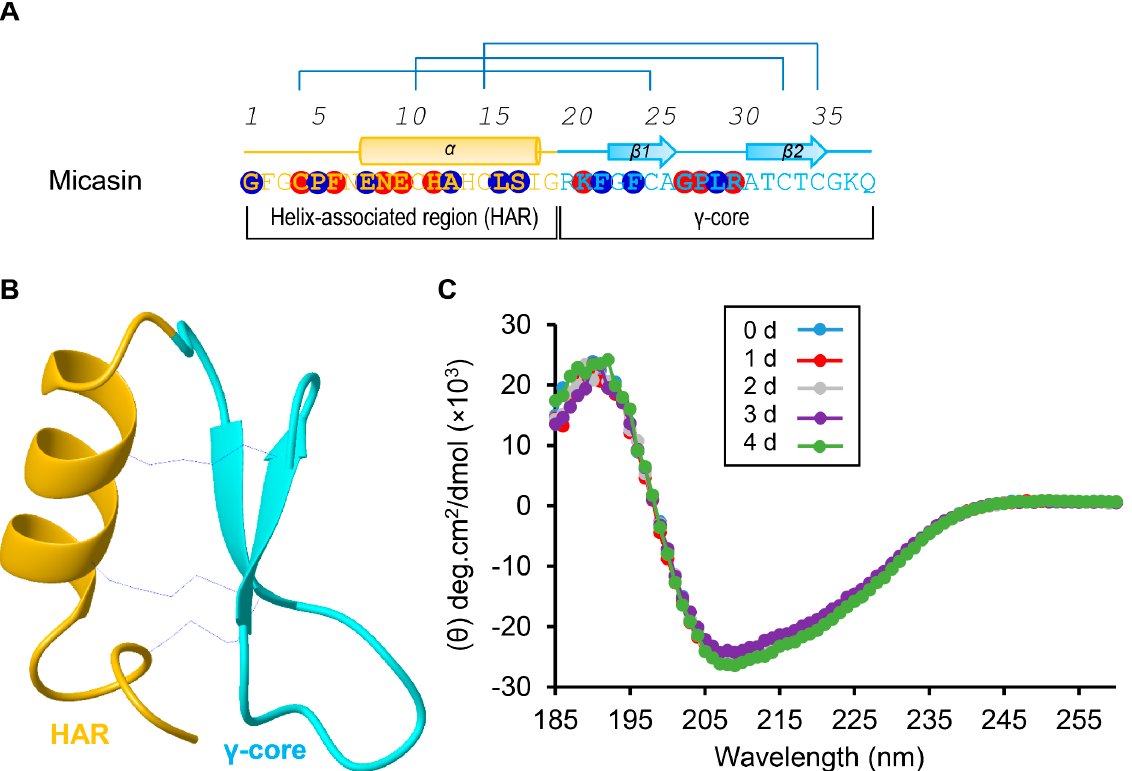
Figure 1. Micasin is a thermally stable CS αβ− type defensin. ( A ) The primary and secondary structures extracted from the structural coordinates of micasin (pdb entry 2LR5). Three disulfide bridges are indicated by lines in blue; α and β represent α− helix and β− strand, respectively. In panels A and B, two subdomains as the N − terminal helix − associated region (HAR) and the C − terminal γ− core region are shown in different colors and circled residues shaded in red and blue represent their contacts with RBD by hydrogen − bonding and hydrophobic interactions, respectively (see Figure 2). ( B ) The ribbon model of micasin resolved from NMR (24). The color scheme is the same as that of panel A. ( C ) Far − ultraviolet CD spectra of micasin after treated 0–4 days at 50 °C.